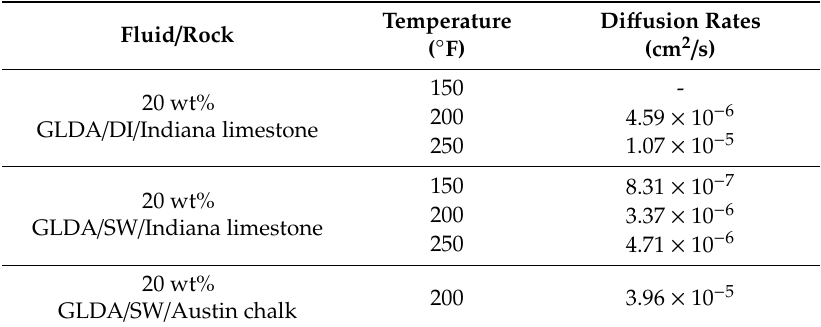
Table 4. Di ff usion rates from the RDA experiments using GLDA with Indiana limestone and Austin chalk calcite roks.